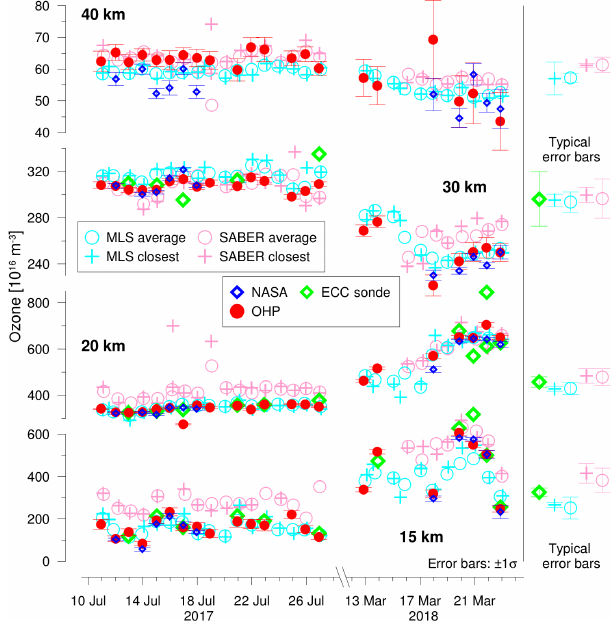
Figure 6. Time series of ozone concentrations measured at different altitude levels during LAVANDE.